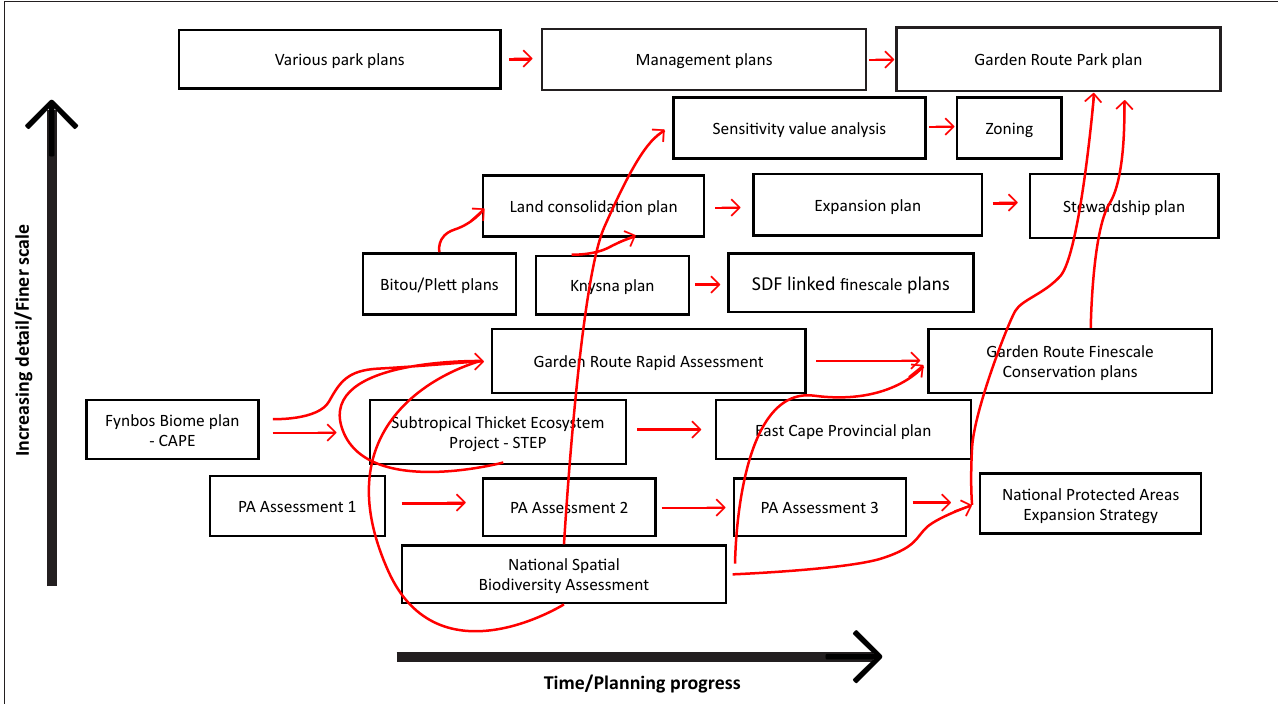
FIGURE 4: Example of an actual planning